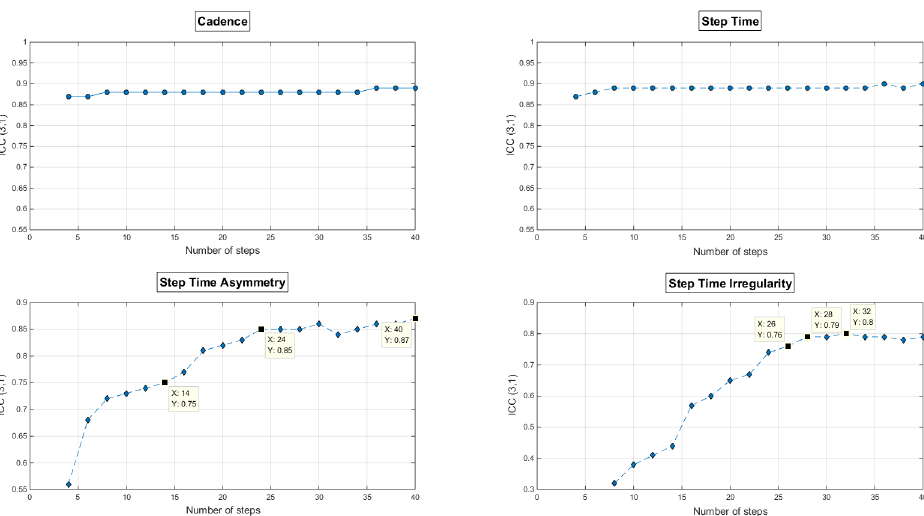
Fig 3. Test-retest reliability of spatiotemporal gait parameters according to the number of analyzed steps Reliability is measured by the intraclass correlation coefficient type of (3,1), or ICC(3,1). The 3 cursor boxes in a graph represent the points to reach ICC = 0.75, plateau of ICC scores, and maximum ICC score, in that order from left to right.